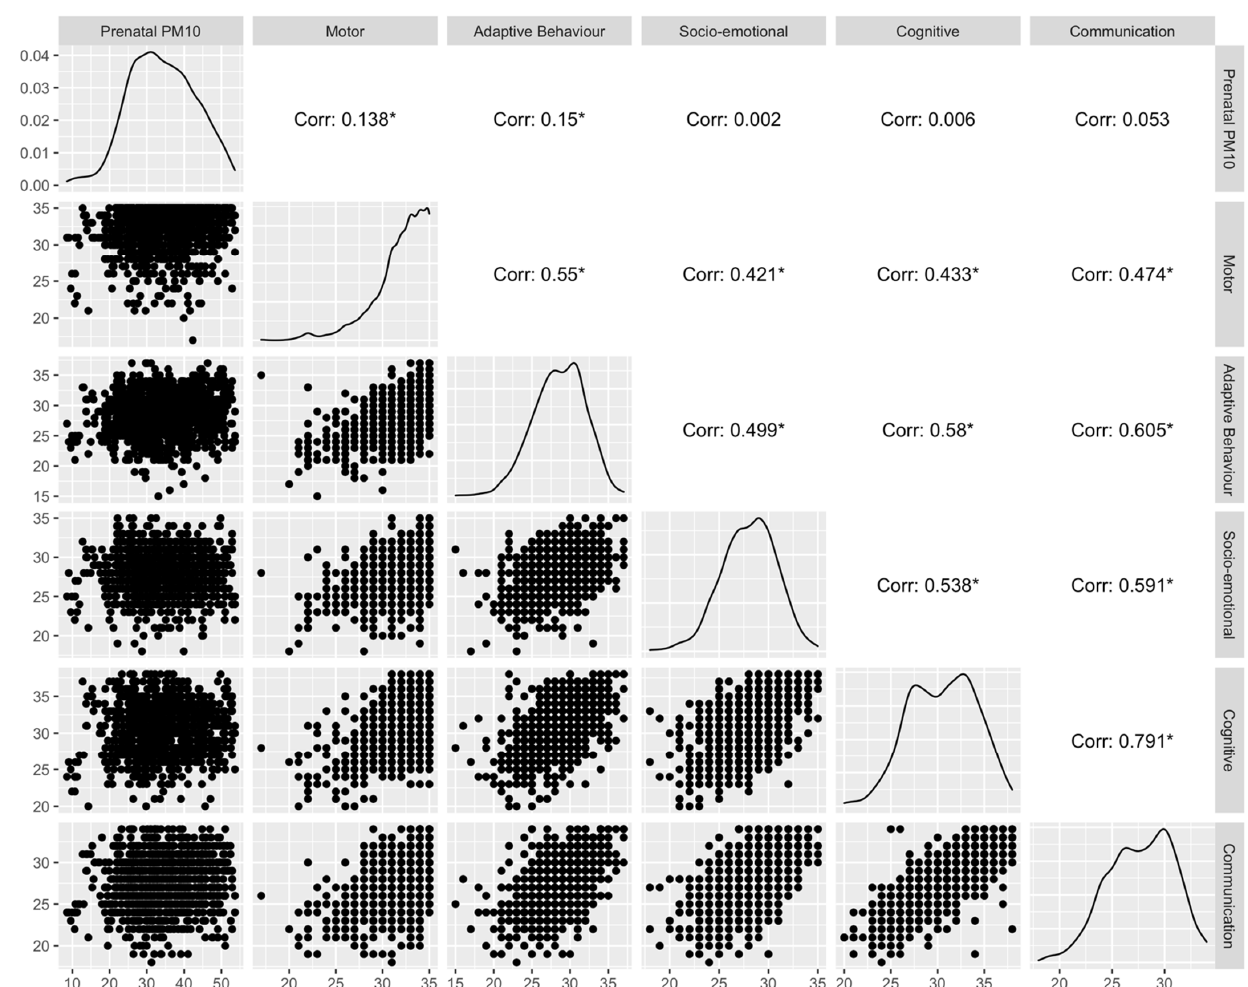
Figure 2. Pairwise marginal distribution and Spearman’s correlation between average prenatal PM 10 concentration and developmental domains (non-parametric correlation test: * p < 0.05). Table 3. Adjusted* estimates of the coefficients for PM 10 concentration, overall and for each trimester of pregnancy, for